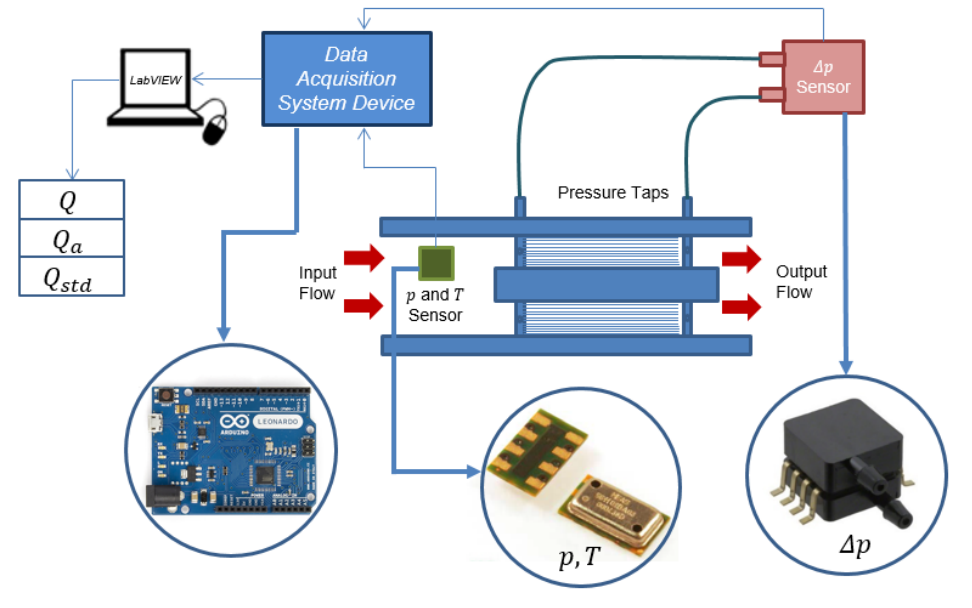
Figure 3. Solution’s setup.